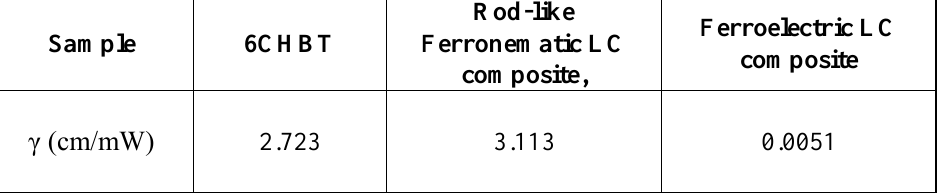
Fig.4: The nonlinear absorption coefficient, (a) pure 6CHBT, (b) Rod-like Ferronematic LC composite, and (c) Ferroelectric LC composite. Table 1: The nonlinear absorption of the three